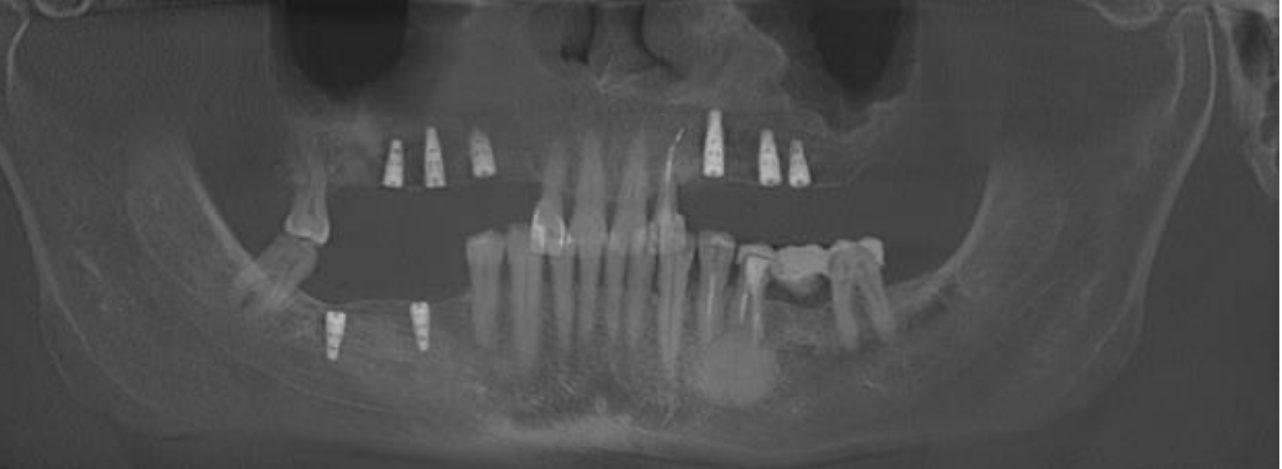
Figure 11. Final result after two years of treatment and dental implant placement.